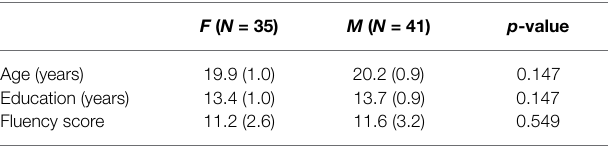
TABLE 1 | Mean (standard deviation) of demographic characteristics of the participants by sex. F ( N =